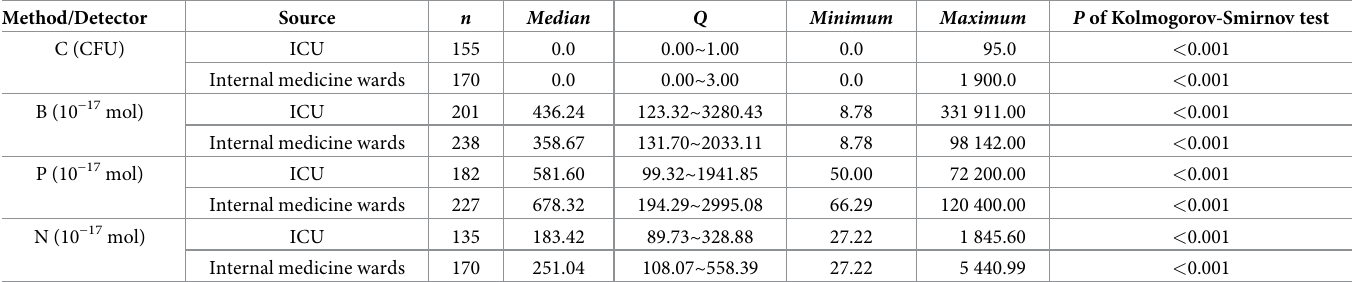
Table 2. Distribution of CFU and ATP content per surface site after disinfection.